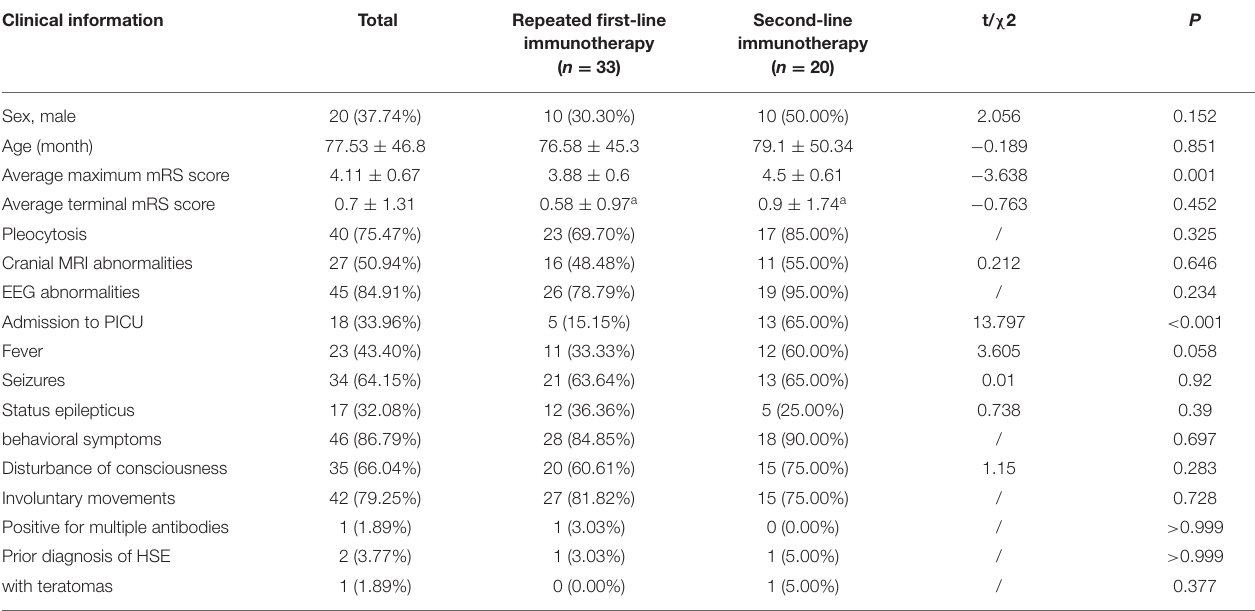
TABLE 4 | The comparison of clinical data between groups of repeated first-line immunotherapy and second-line immunotherapy in patients with anti-NMDAR encephalitis, case (%). Clinical information